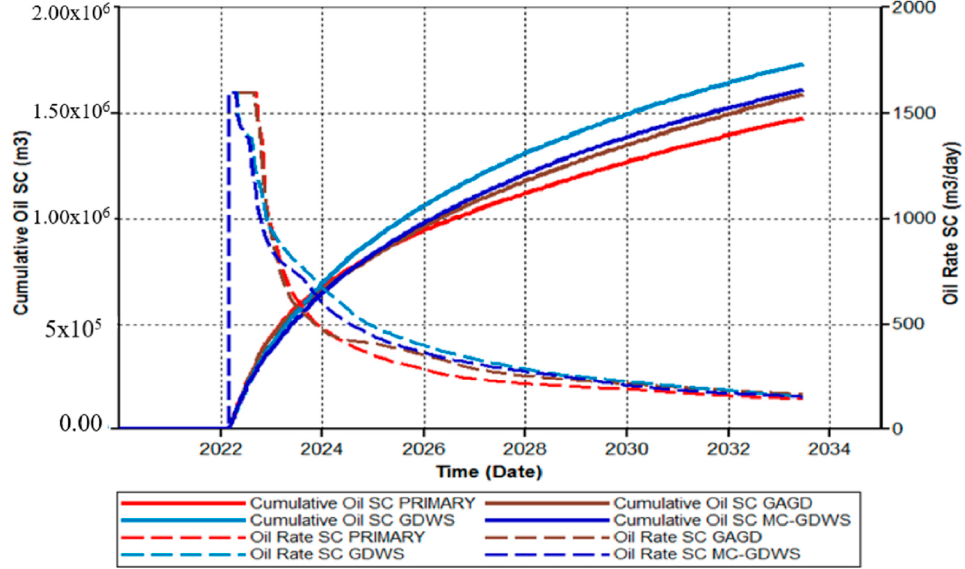
Figure 6. Cumulative oil production and daily oil production rate generated by TC-GDWS-AGD, GDWS-AGD, GAGD, and primary (base-case) PUNQ-S3 simulations.